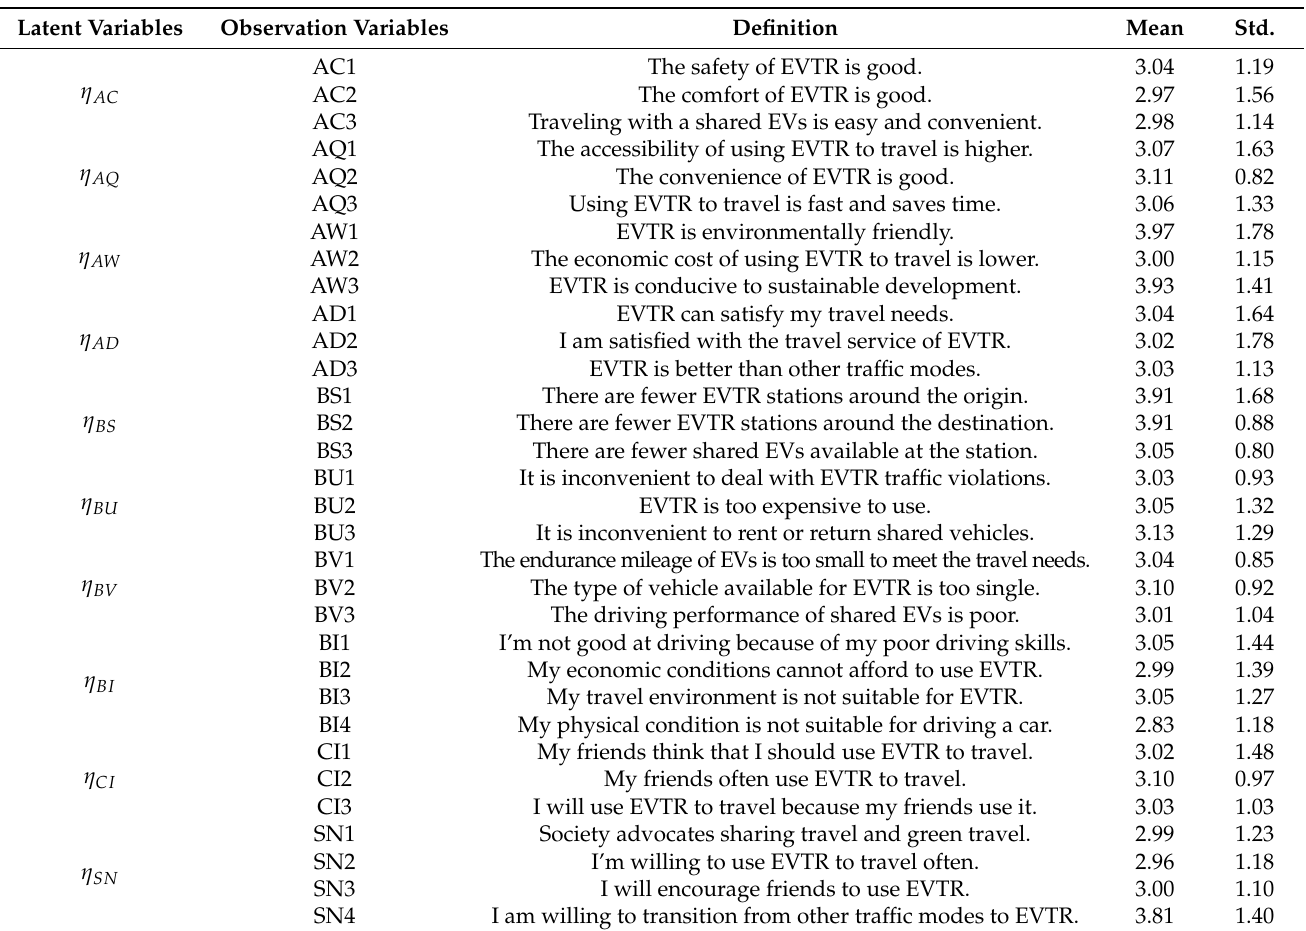
Table 2. Statistics of latent variables of respondents.